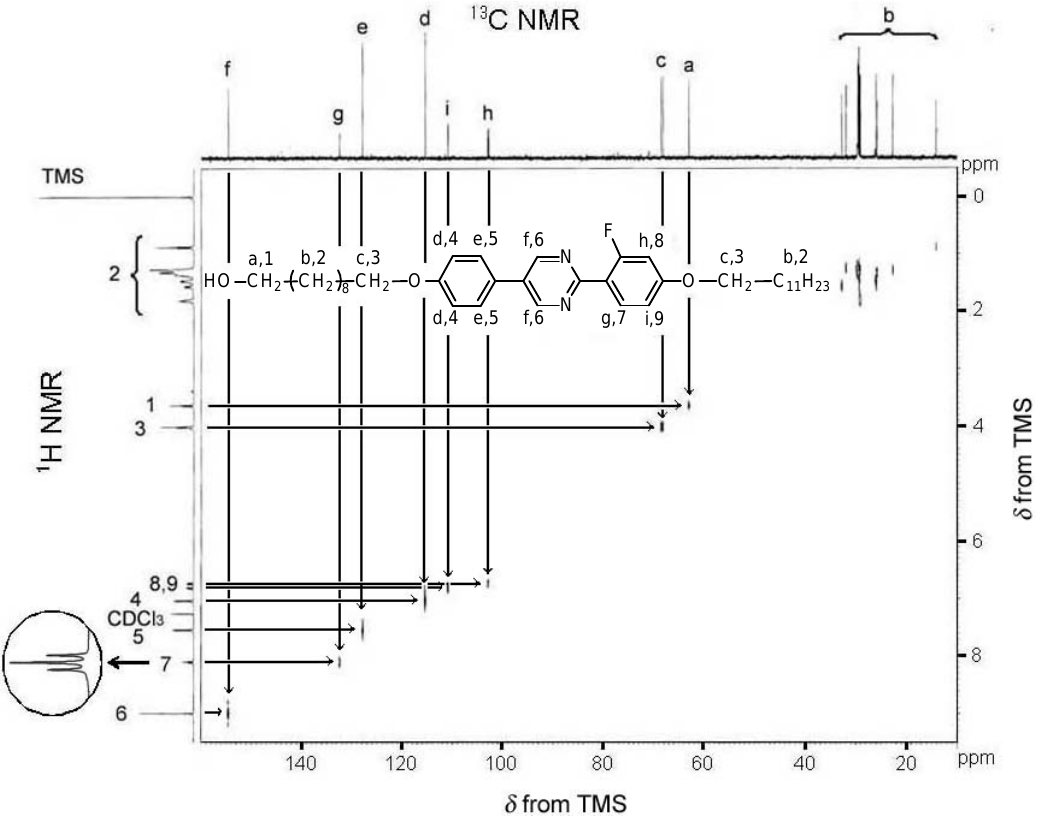
Figure 1. 1 H − 13 C hetero-nuclear multiple quantum coherence (HMQC) NMR of 10-[4- [2-(4-dodecyloxy-2-fluorophenyl)-pyrimidin-5-yl]-phenoxy]-decan-1-ol (compound 2 ). The inset shows 1 H-NMR signal of a proton positioned at